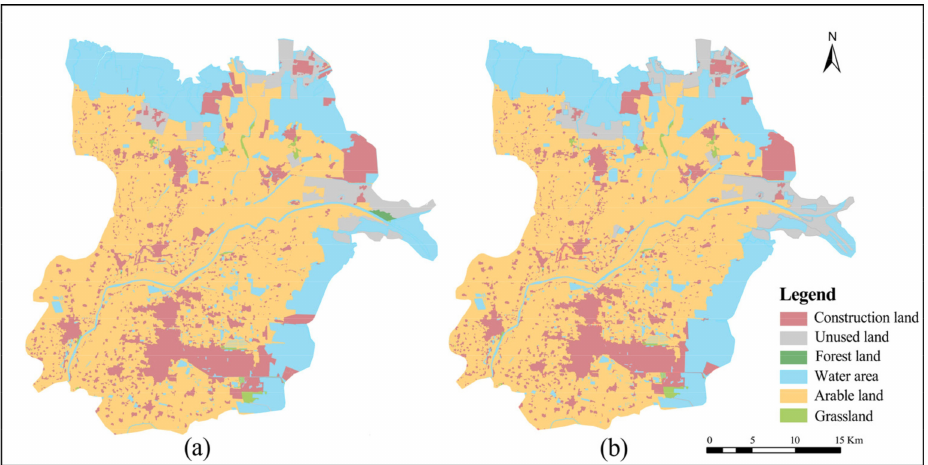
Figure 10. ( a ) Map of land use types in the study area in 2016. ( b ) Map of land use types in the study area in 2019.